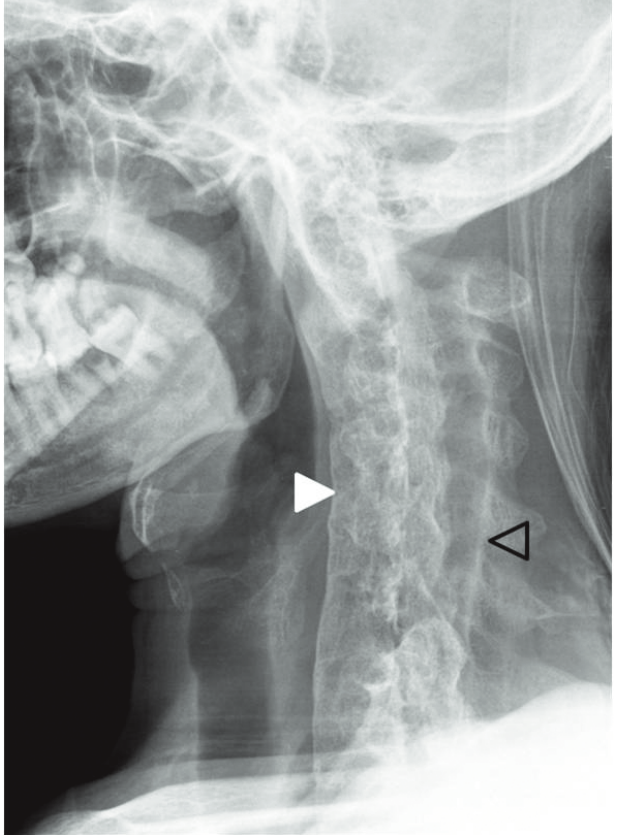
Fig. 2. Lateral cervical spine X-ray. The white arrowhead indicates syndesmophytes, representing calcification of the anterior portion of the annulus fibrosis. Calcification of the interspinous ligaments can also be seen (open arrowhead).